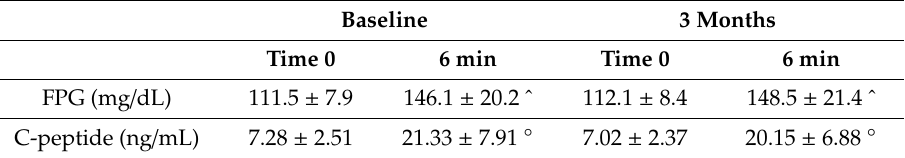
Table 5. Glucagon test at the baseline, and after 3 months in the placebo group.